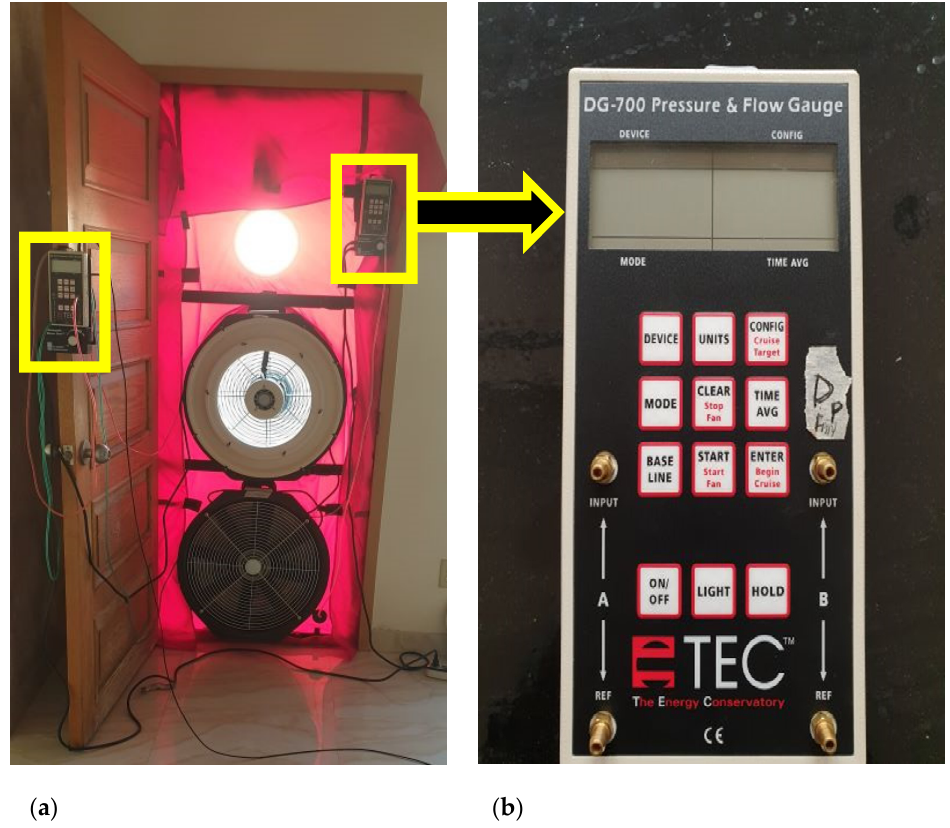
Figure 7. Used ( a ) BDT assembly and ( b ) pressure gauges.